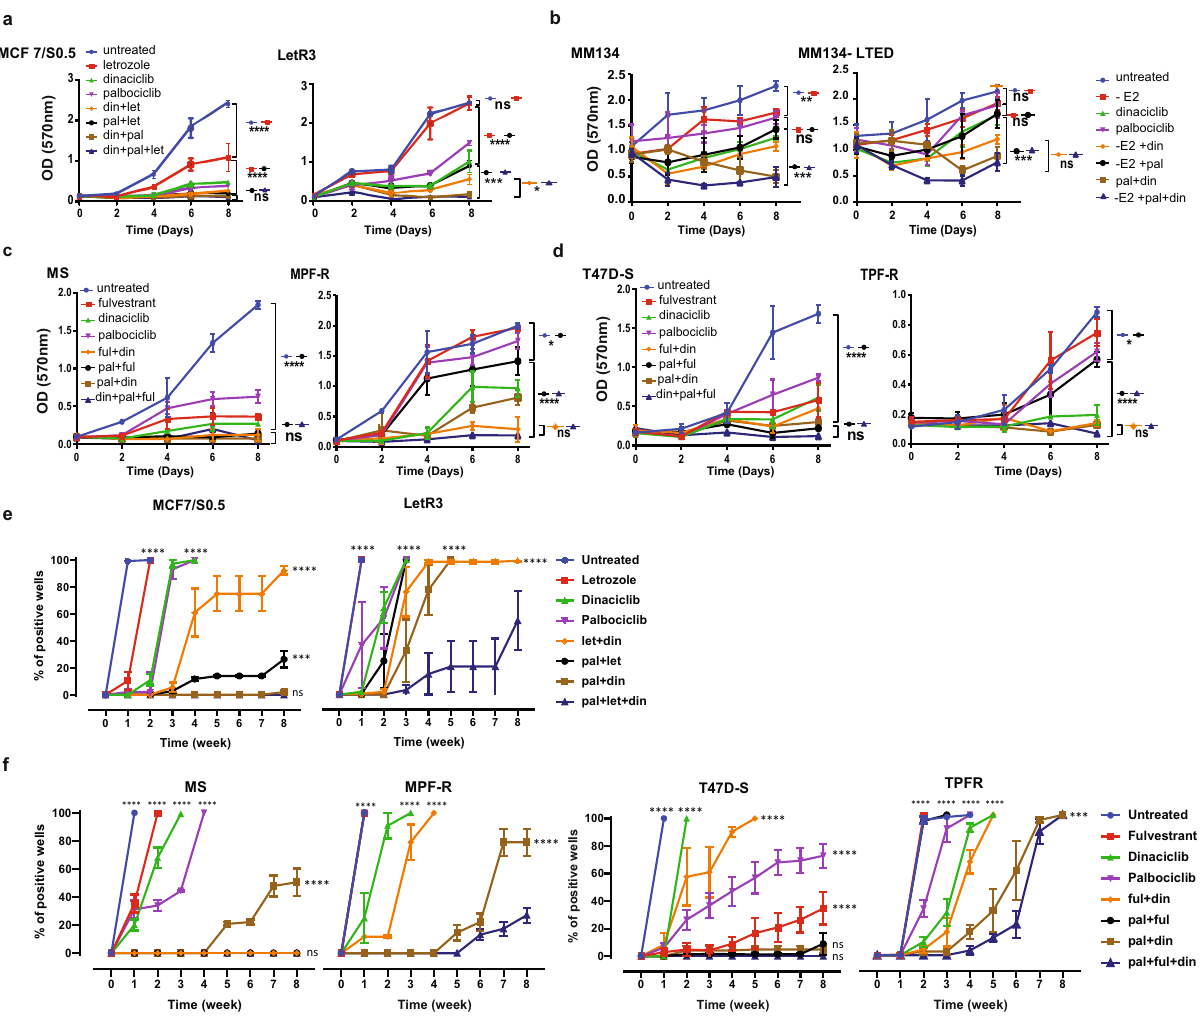
Fig. 3 The triple combination with CDK2i, CDK4/6i and ET delays emergence of resistance in AI-resistant and combined CDK4/6i and fulvestrant-resistant ER + BC cells. Resistant cells (LetR3, MM134-LTED, MPF-R, and TPF-R) and sensitive cells (MCF7/S0.5, MM134, MS, T47D-S, respectively) were used. a – d Cell growth assays were performed over 8 days of treatment with AI (letrozole (let) 1 μ M; or absence of E2, 1 μ g/ ml), fulvestrant (ful, 100 nM), CDK2i dinaciclib (din, 10 nM), or CDK4/6i palbociclib (pal, 150 nM) alone or in different combinations, as assessed by crystal violet assay. The data represent the mean of three biological replicates ± SD. e , f Outgrowth of resistant colonies was evaluated following treatment with AI (letrozole (let), 1 μ M; or absence of E2, 1 μ g/ml), fulvestrant (ful, 100 nM), CDK2i dinaciclib (din, 5 nM), or CDK4/6i palbociclib (pal, 150 nM) alone or in different combinations over a period of 8 weeks. Wells showing ≥ 50% con fl uency were considered positive. Statistically signi fi cant differences calculated by one-way ( a – d ) or two-way ( e and f ) ANOVA are shown as ns p > 0.05, *p ≤ 0.05, **p ≤ 0.01, ***p ≤ 0.001, and ****p ≤